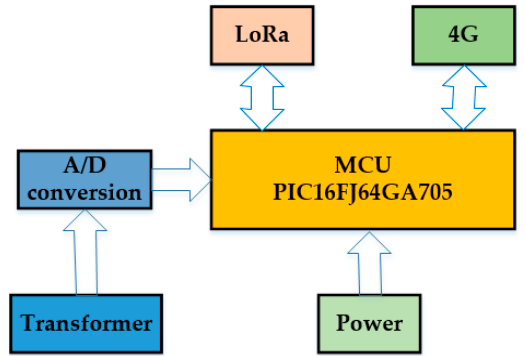
Figure 9. System structure diagram of central controller.